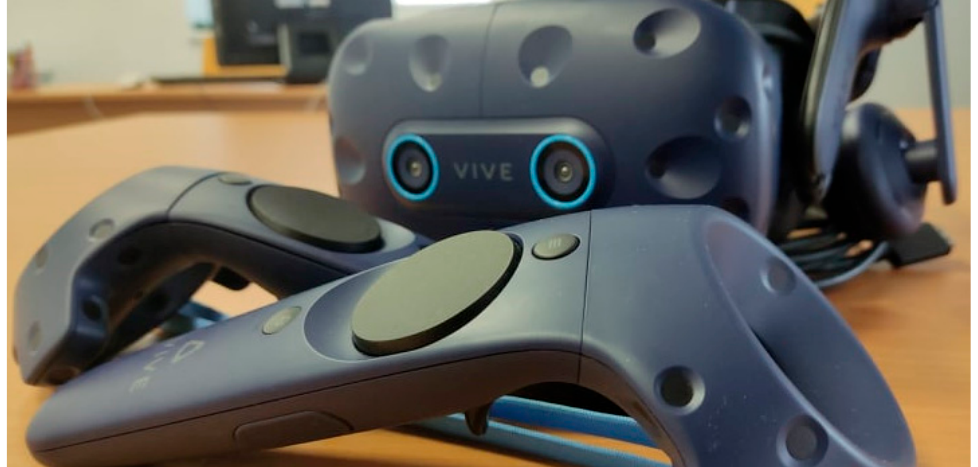
Figure 12. HTC Vive Pro (Tchao-jüan, Tchaj-wan).